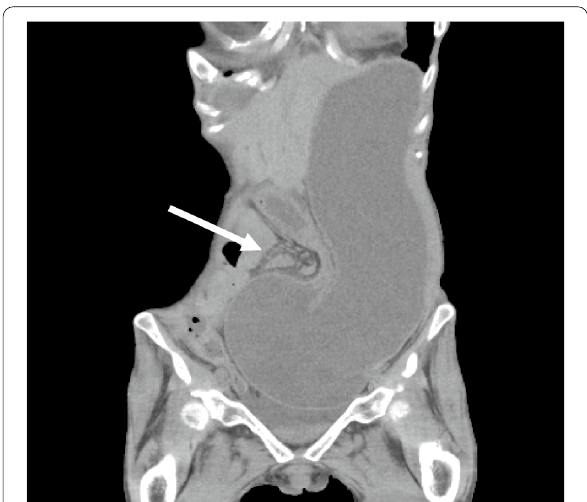
Fig. 2 CT showed the stomach was markedly dilated due to the obstruction near the pylorus caused by the lifted sigmoid colon. A white arrow points to the sigmoid